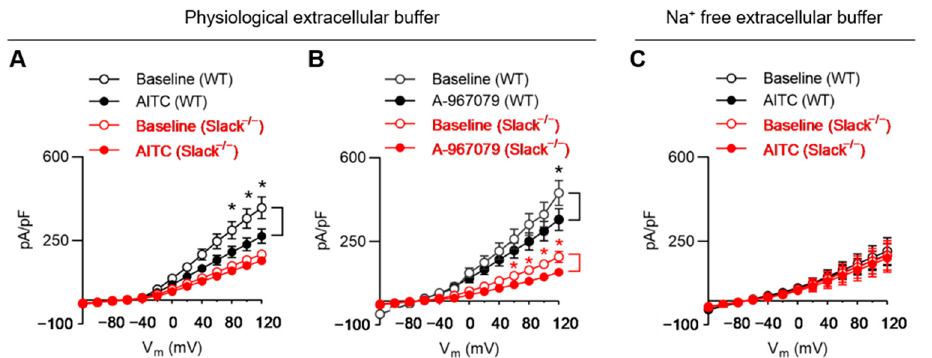
Figure 5. AITC-mediated modulation of potassium currents in IB4 + sensory neurons from WT and Slack − / − mice. ( A ) IV relations of outward potassium currents (I K ) obtained in whole-cell patch-clamp recordings in IB4 + sensory neurons from 4 WT ( n = 18 cells) and 4 Slack − / − mice ( n = 13 cells) before and after AITC (200 µM) application in the physiological extracellular buffer. Note that in this experimental setting (which includes 2 mM Ca 2+ and 140 mM Na + in the external solution), TRPA1 activation led to a significant reduction in I K in sensory neurons from WT but not Slack − / − mice. ( B ) IV relations of I K in sensory neurons from 3 WT ( n = 13 cells) and 3 Slack − / − mice ( n = 12 cells) before and after application of the TRPA1 antagonist A-967079 (10 µM) in the physiological extracellular buffer. The TRPA1 antagonist significantly reduced I K in sensory neurons from both WT and Slack − / − mice. ( C ) IV relations of I K in sensory neurons from 3 WT ( n = 9 cells) and 3 Slack − / − mice ( n = 8 cells) before and after AITC (200 µM) application in a Na + free extracellular buffer. In this experimental setting (which includes 2 mM Ca 2+ but no Na + in the external solution), TRPA1 activation did not alter I K in sensory neurons from both WT and Slack − / − mice. Data are presented as mean ± SEM. * p < 0.05.